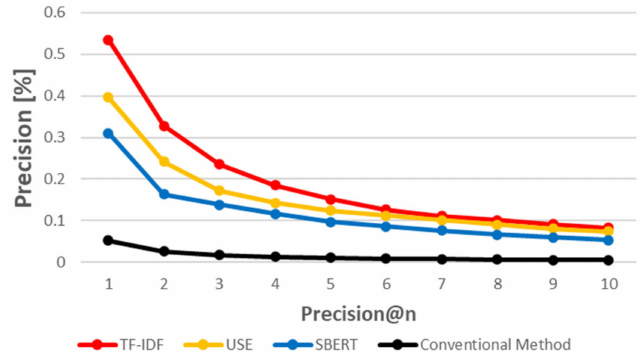
Figure 10. Precision for each approach.